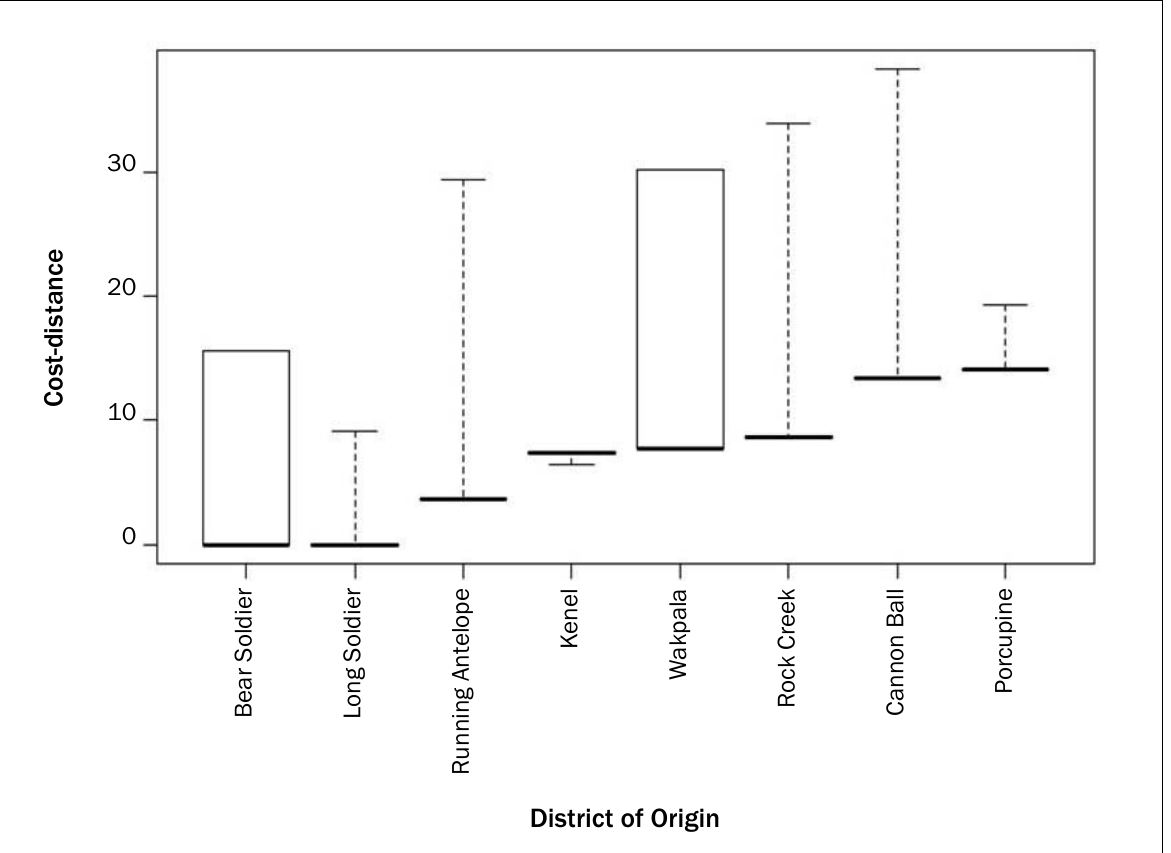
Figure 3. Cost-distance Per Trip to Market (N=277) Made by Voucher Recipients